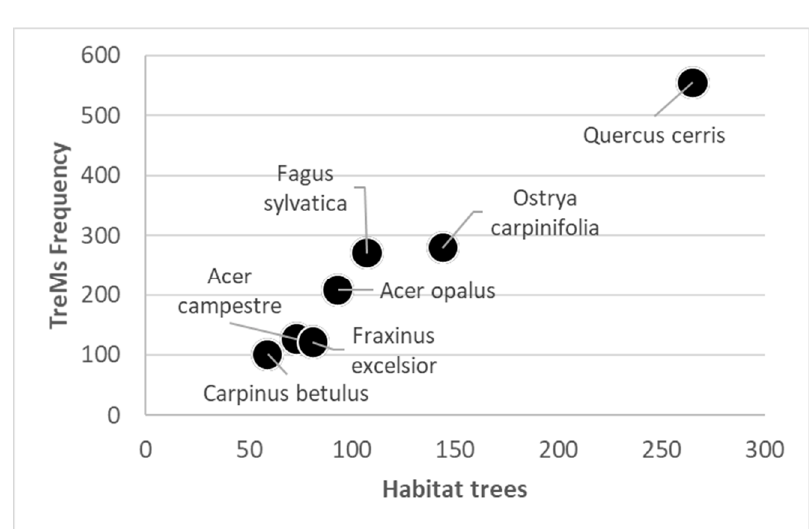
Figure A3. Abundance of TreMs and Habitat Trees per species.